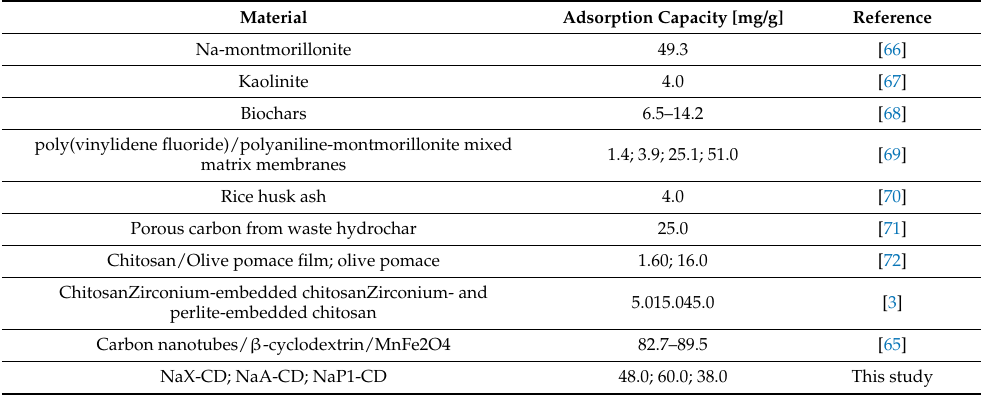
Table 7. Comparison of the adsorption capacity of TC on different adsorbents.